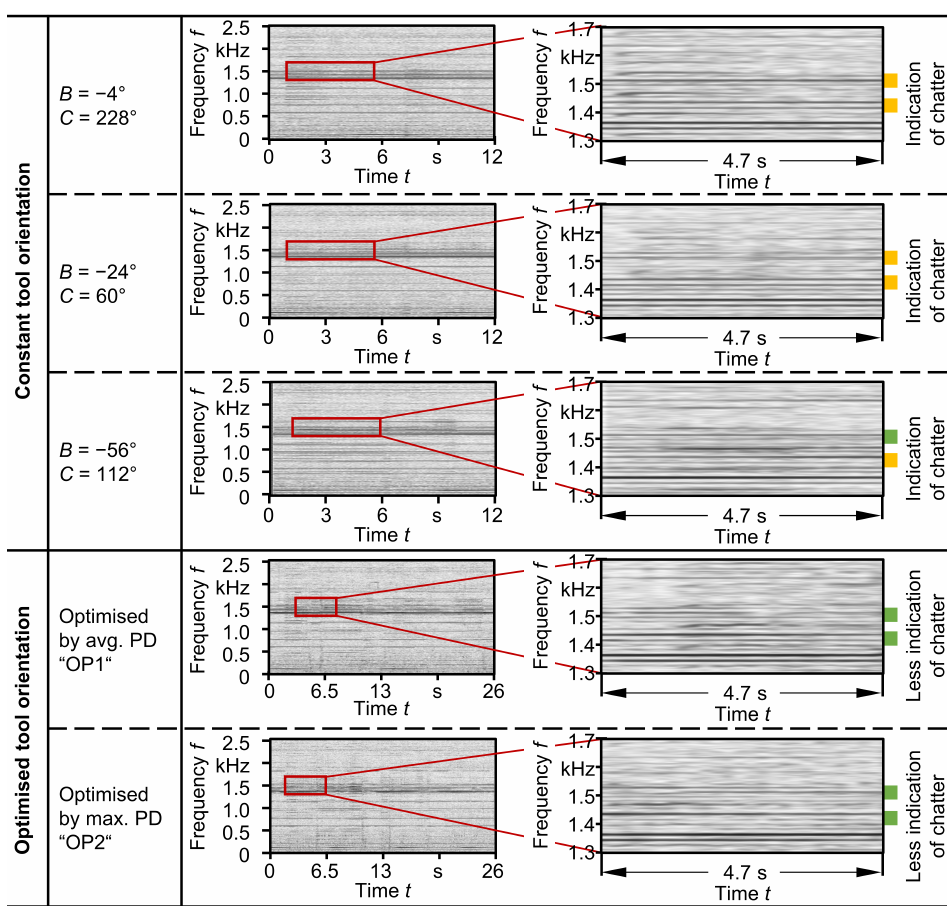
Figure 17. Acoustic emissions measured in the validation